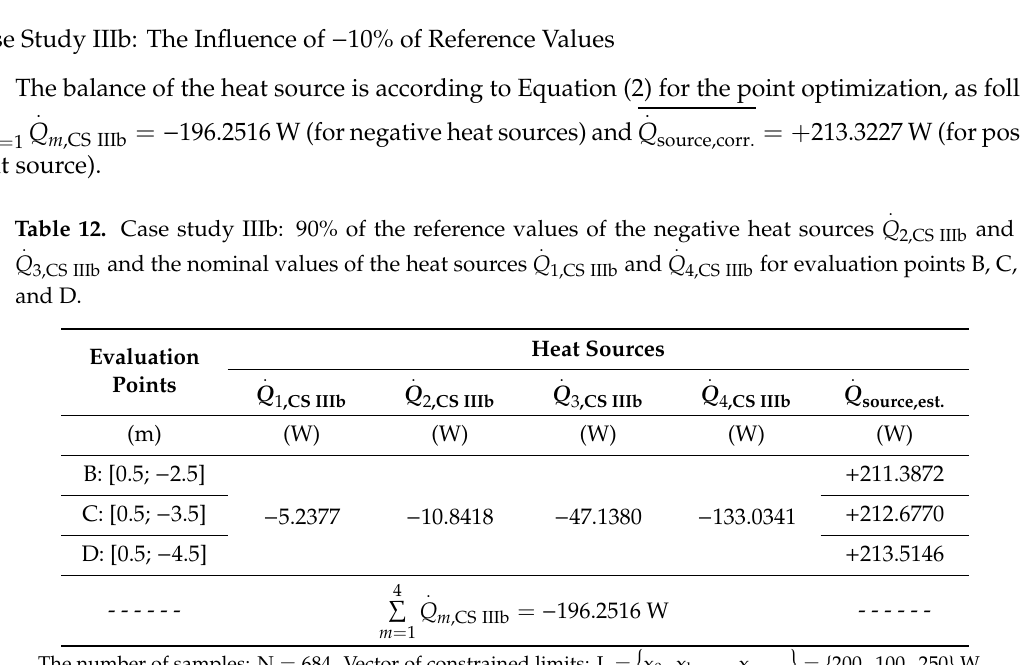
. Q source,est. and consequent corrections